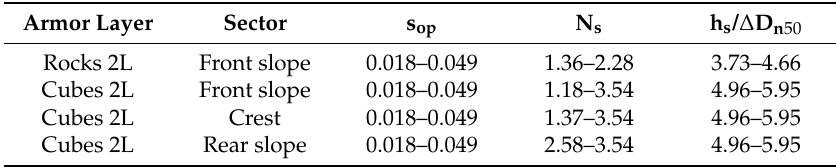
Table 4. Ranges of validation for Equation (5).